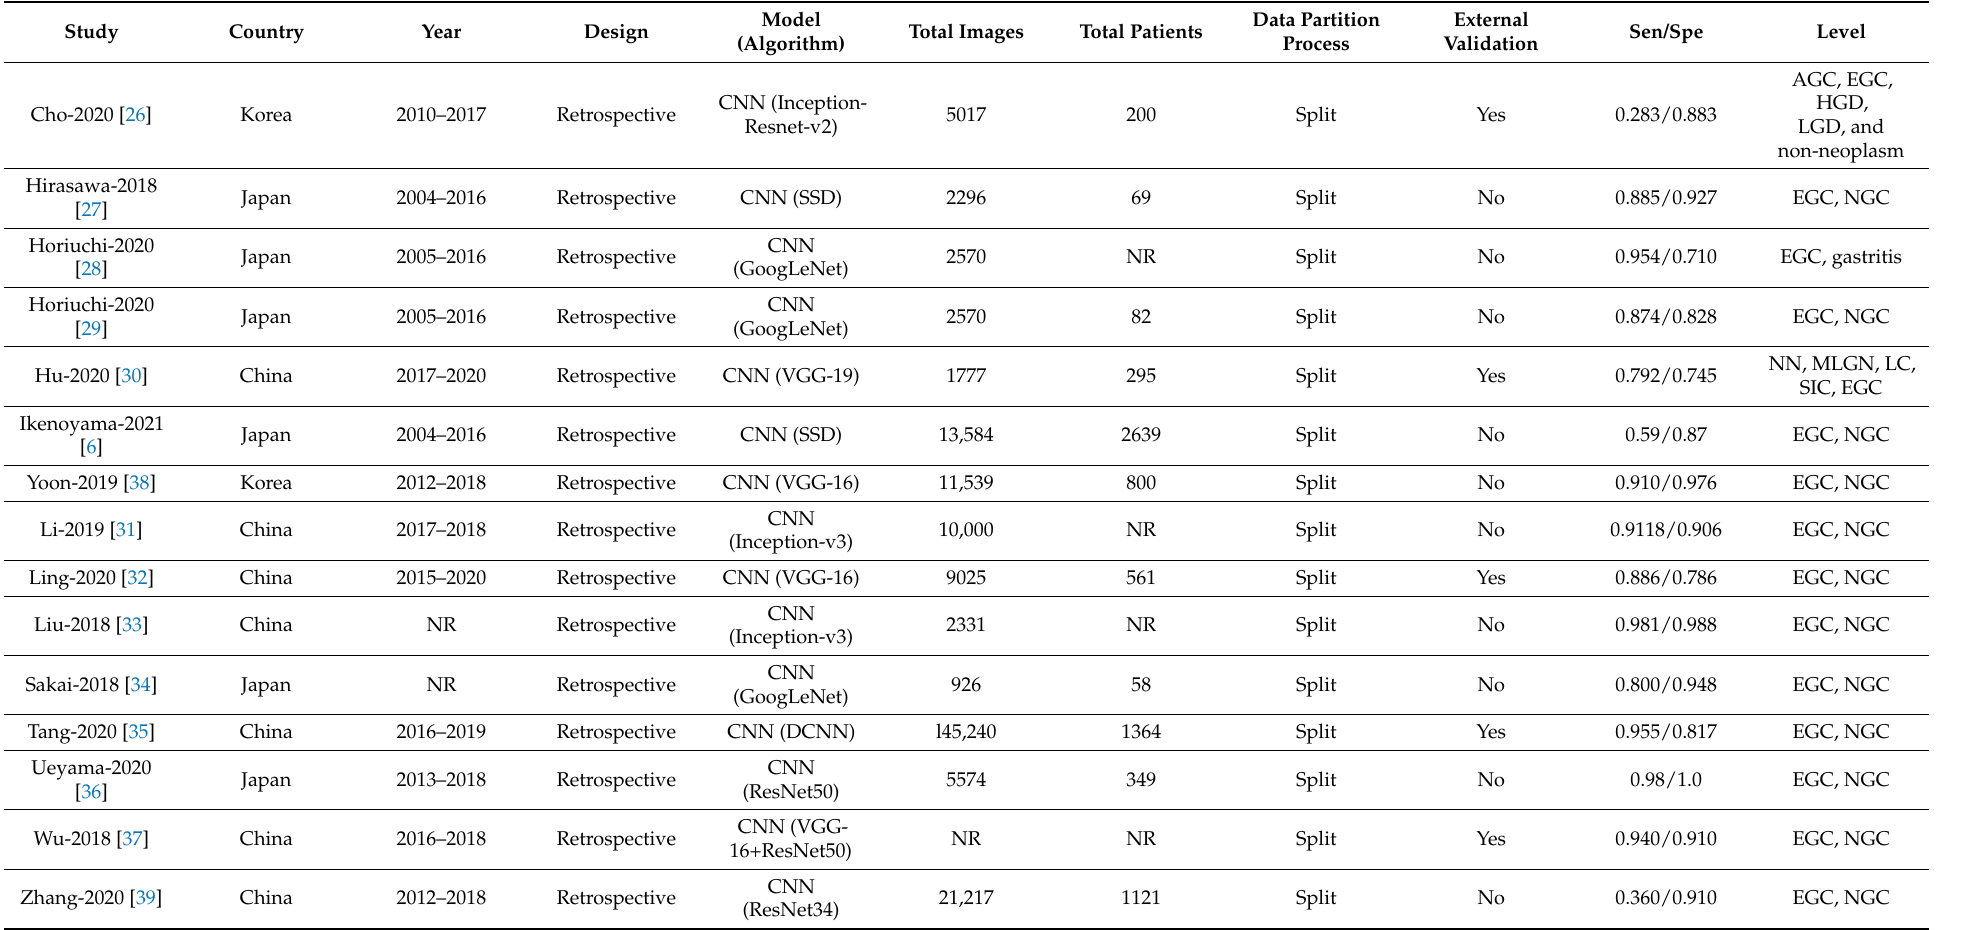
Table 1. Baseline characteristics of included